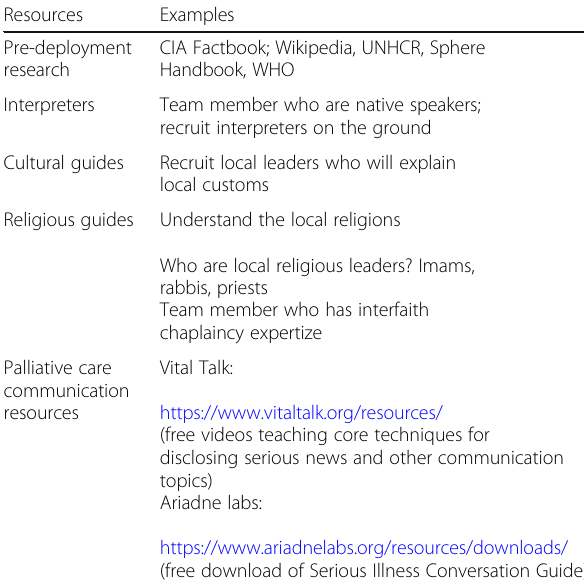
Table 8 Resources for communication